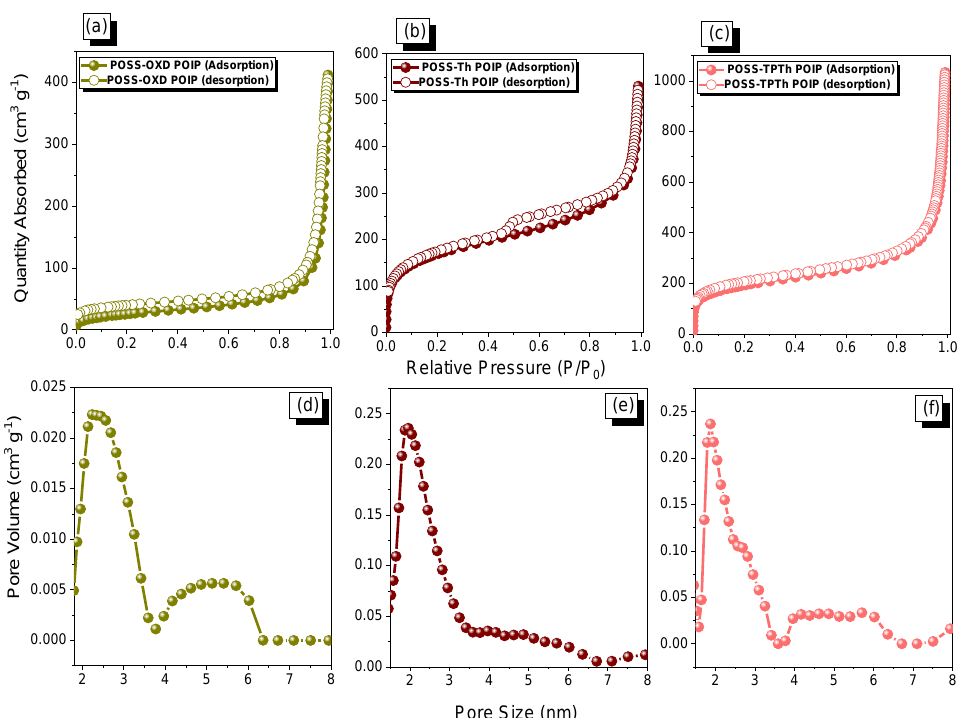
Figure 4. ( a – c ) N 2 adsorption/desorption isotherms and ( d – f ) pore diameter patterns of the ( a , d ) POSS-OXD, ( b , e ) POSS-Th, and ( c , f ) POSS-TPTh POIPs. Scanning electron microscopy (SEM) and transmission electron microscopy (TEM) revealed (Figure 5) that the morphologies of the POSS-OXD, POSS-Th, and POSS-TPTh POIPs were irregular clusters of tiny spherical particles. Furthermore, energy dispersive X-ray (EDX) spectroscopy of the SEM images (Figure S11) demonstrated the presence of C, N, O, and Si atoms in the POSS-OXD POIP and C, O, Si, and S elements in both the POSS-Th and POSS-TPTh POIPs.